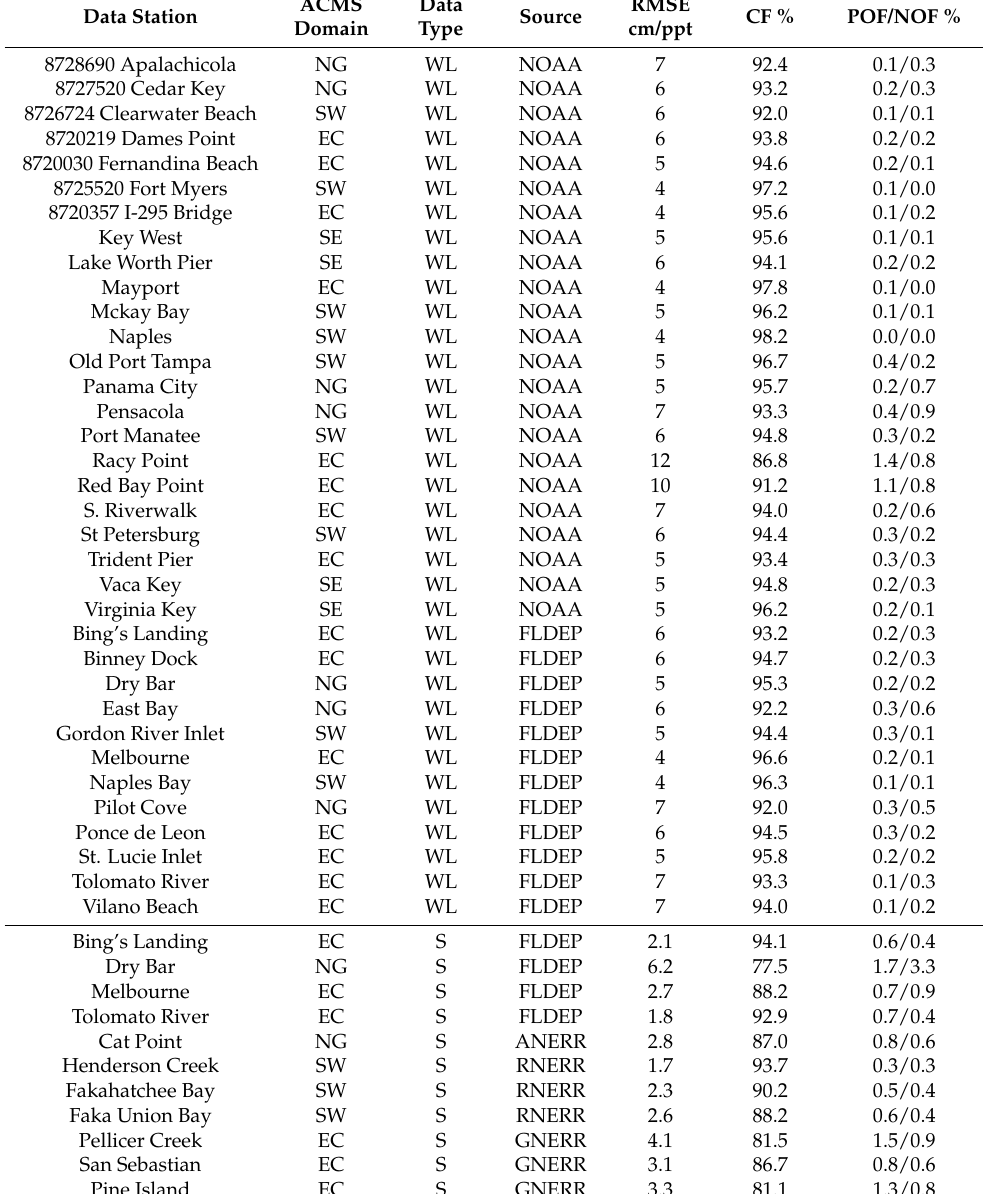
Table 2. Errors statistics calculated based on ACMS forecasts during 1 June 2015–30 November 2015. Units for root mean square error (RMSE) are cm for water level data and ppt for salinity. Green indicates that the errors are within acceptable limits (>90% for CF and <1% POF/NOF), red indicates